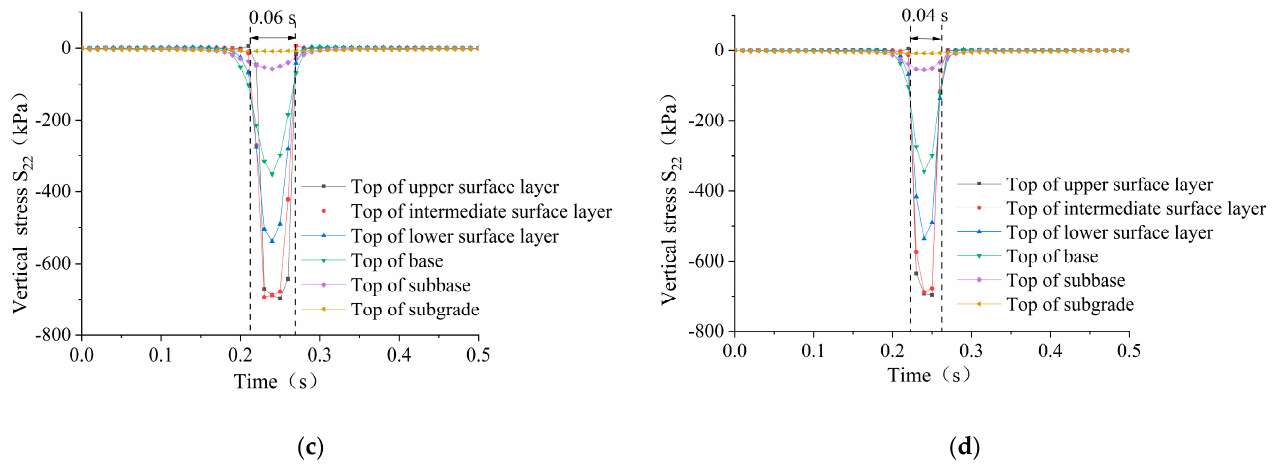
Figure 7. Variation in vertical stress over time at initial speeds of ( a ) 10 km/h, ( b ) 20 km/h, ( c ) 30 km/h, and ( d ) 40 km/h.